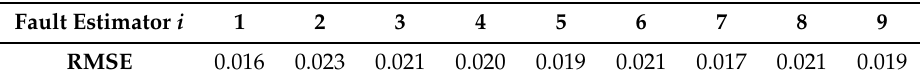
Table 5. Fault estimator performance in terms of RMSE.